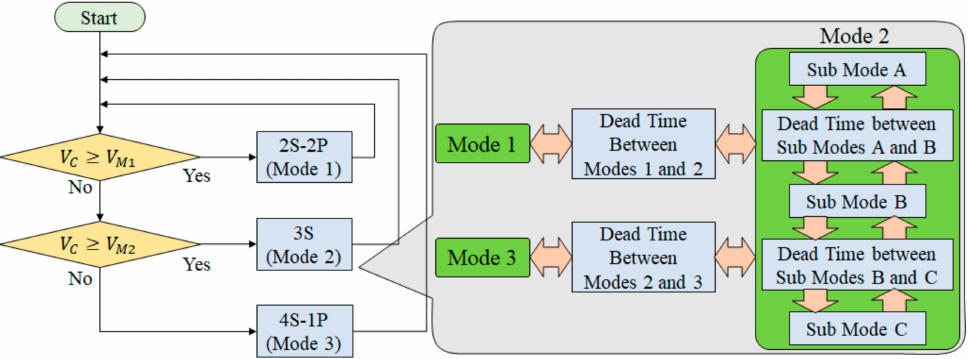
Figure 13. Flowchart of reconfiguration